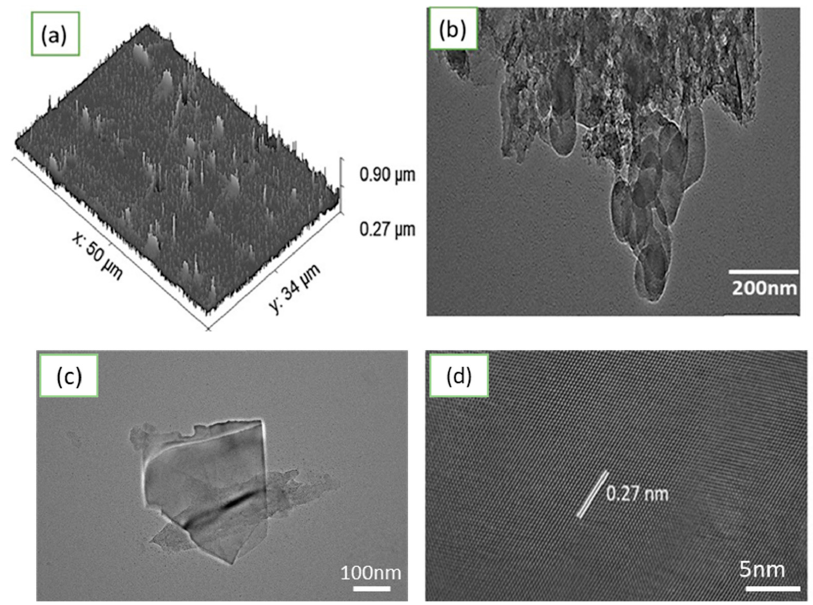
Figure 4. ( a ) The surface and cross-section morphology of 2D MoS 2 nanosheets using the ImageJ program, and ( b – d ) TEM of 2D MoS 2 nanosheets at different scale bars.